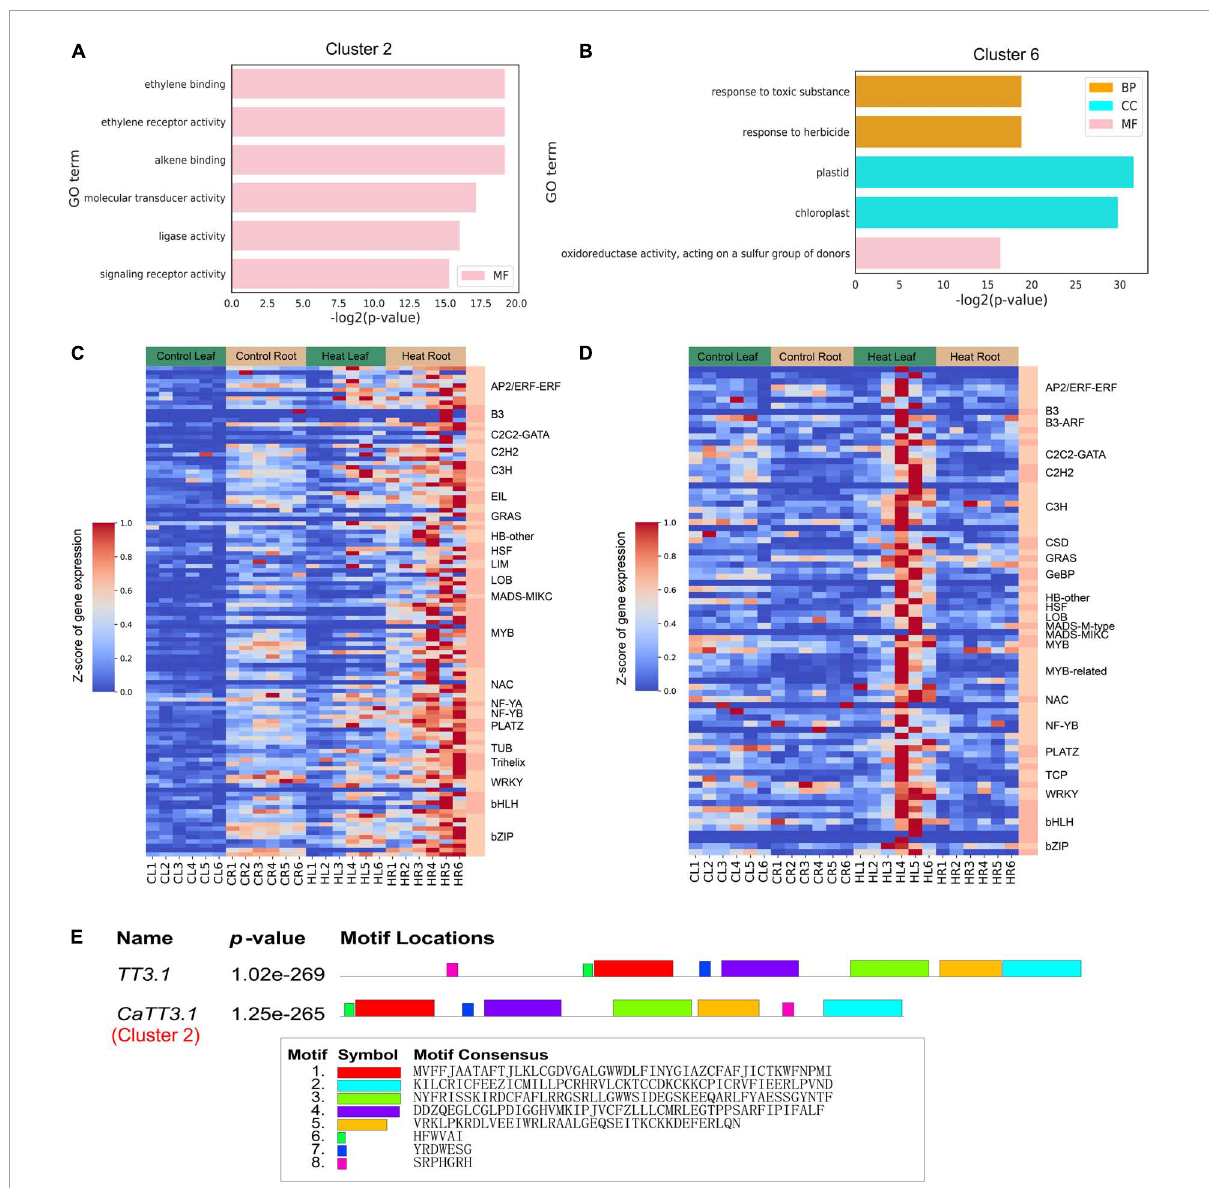
FIGURE4 Gene ontology (GO) and heat-responsive transcriptional modulators of Cluster 2 and 6. (A,B) GO enrichment results in cluster 2(A) and cluster 6(B). GO terms with FDR < 0.01 are shown. CC, cellular component; MF, molecular function; BP, biological process. The full lists of DEGs and GO terms can be found in Supplementary Tables 3, 4 . (C,D) Distribution and expression of transcription factors identified in cluster 2(C) and cluster 6(D). (E) Alignment of TT3.1 and CaTT3.1 protein sequences. The conserved motifs are highlighted and